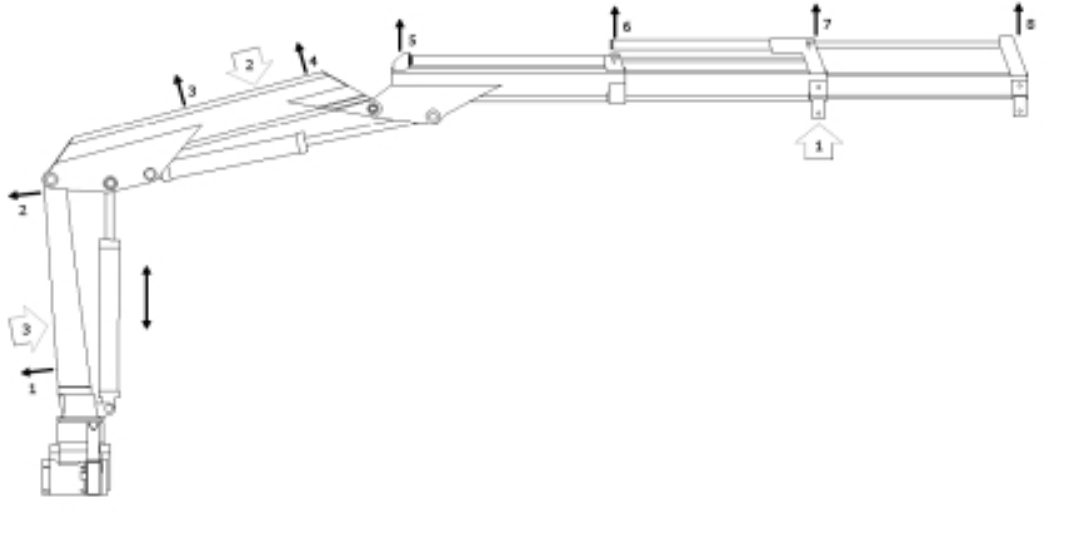
Fig. 1. Vehicle crane HIAB-022-2L. The numbered broad arrows indicate the damage locations, the double arrow is the excitation, and the single arrows are the response locations.